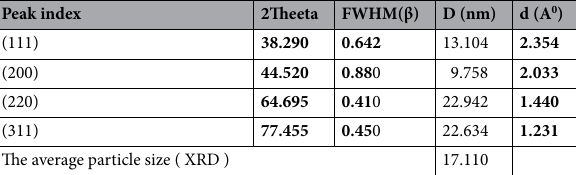
Table 1. The average particle size (D) calculated from XRD, d-spacing of different diffracting plans.